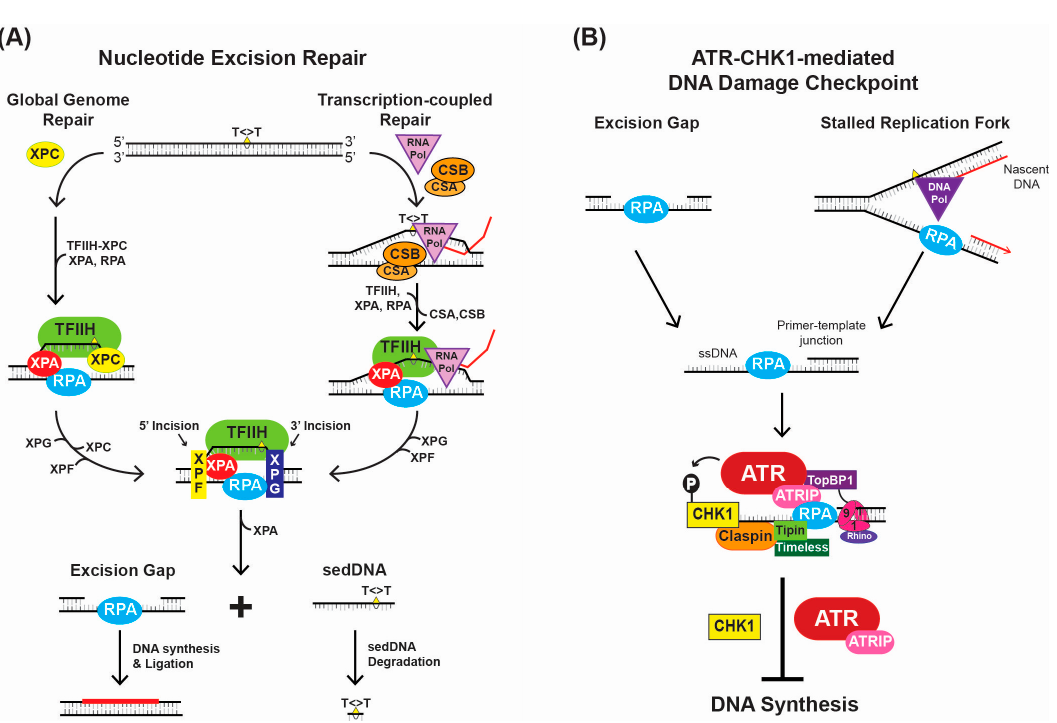
Figure 2. Schematic of nucleotide excision repair and the ATR-CHK1-mediated DNA damage checkpoint. ( A ) In nucleotide excision repair, UV photoproducts (denoted by T<>T and